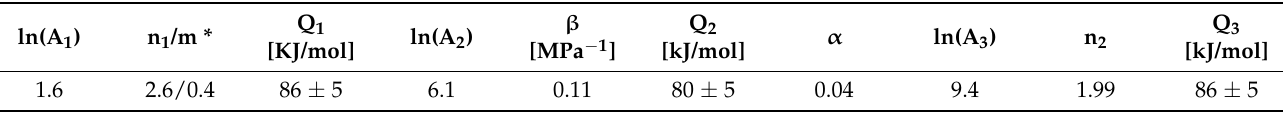
Figure 5. Plots of ( a ) ln of 50%. Table 2. The determined constants of the Arrhenius-type constitutive hyperbolic-sine equation model (ACE) at a strain of 50% of the investigated